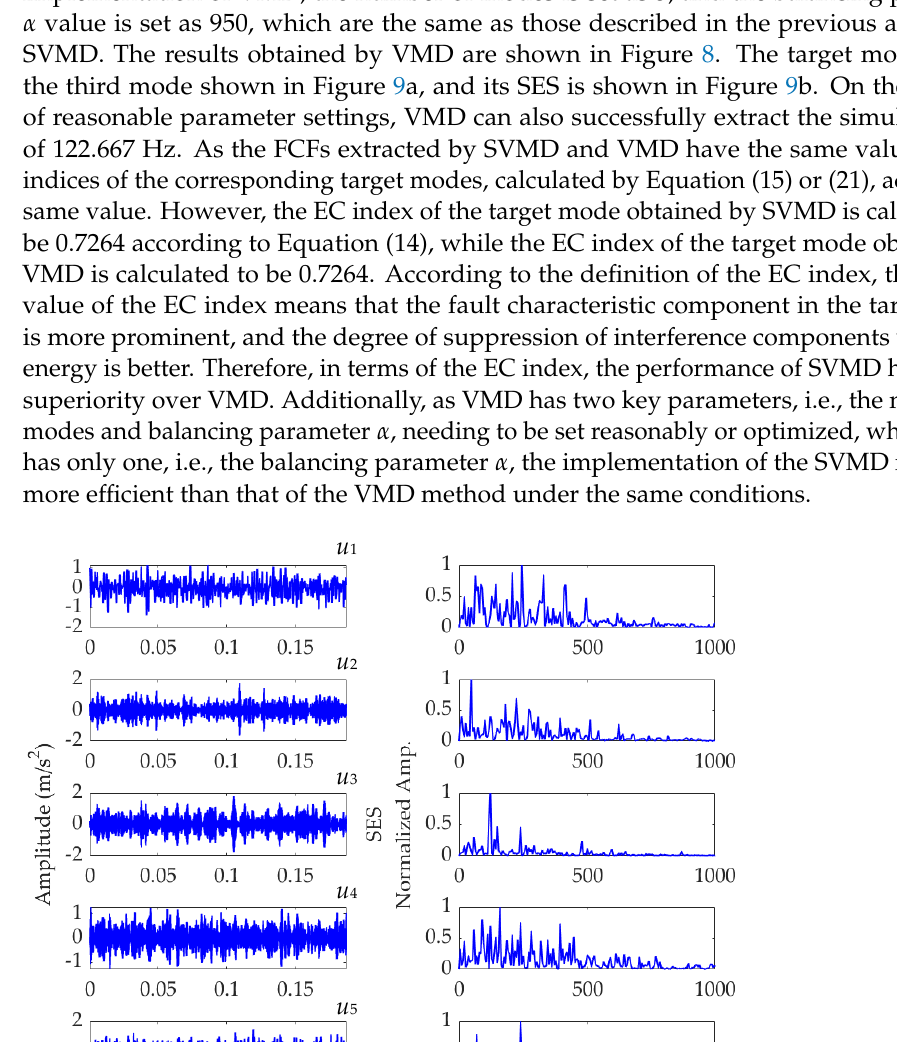
( b ) Figure 9. The target mode obtained by VMD: ( a ) time − domain waveform and ( b ) SES. 6. Experimental Evaluation In this section, the effectiveness of the proposed rolling bearing fault diagnosis method is investigated using three experimental vibration datasets. We focus on the fault feature extraction for the inner race, outer race, and balls of the rolling bearing. Based on this, we use the proposed method to extract the actual FCF from the vibration dataset of the rolling bearing and then compare the possible FCF with the theoretical FCFs of the three components mentioned above. The component whose FCF is closest to the actual FCF can be considered as the faulty component. This is the basic principle of the proposed method for rolling bearing fault diagnosis. According to the previous analysis, we express the theoretical FCFs of the inner race, outer race, and balls of the rolling bearing as f ir , f or , and f ba , respectively. Then, the PA index shown in Equation (15) needs to be specifically modified as Equation (22):